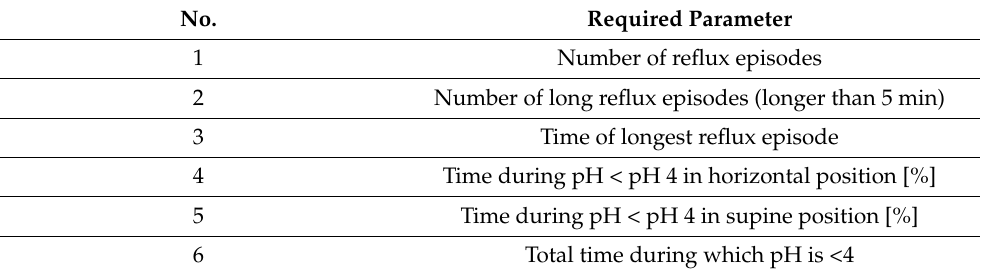
Table 1. Parameters used to calculate the total DeMeester count